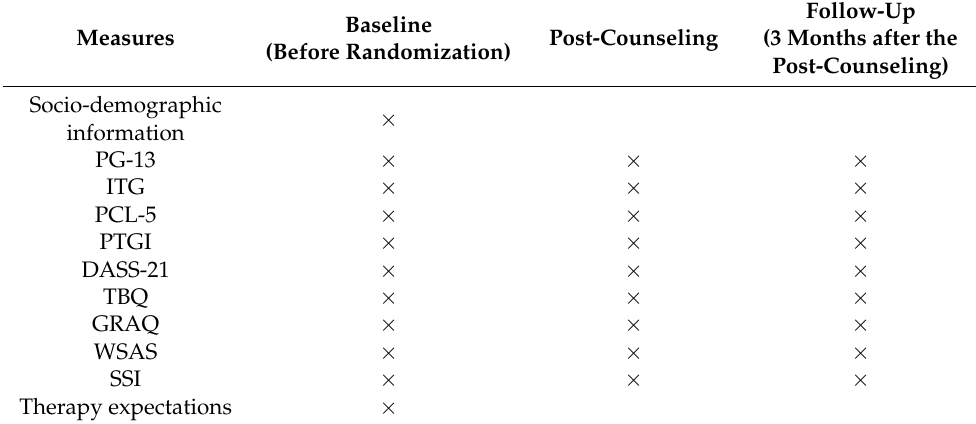
Table 2. Schedule of